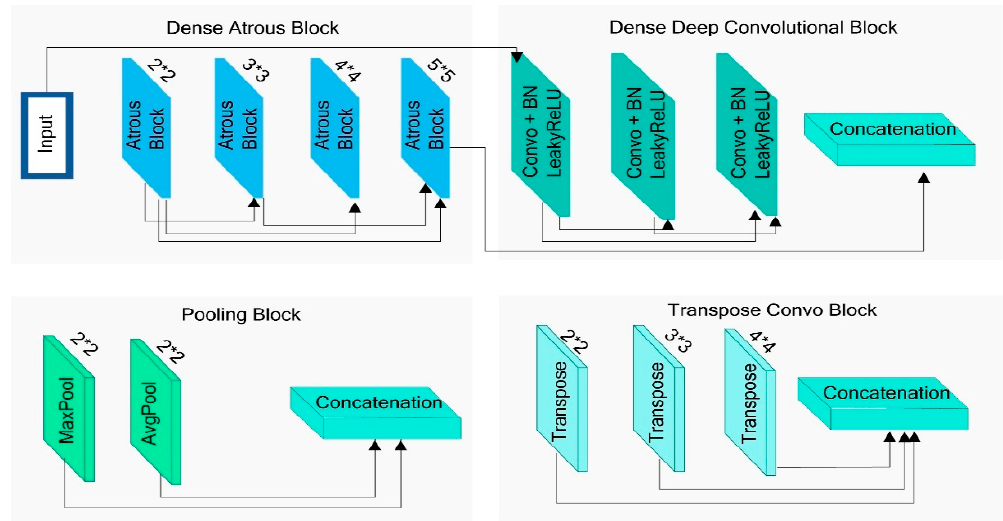
Figure 5. An architecture of our DA, pooling, and transposed convolution blocks.